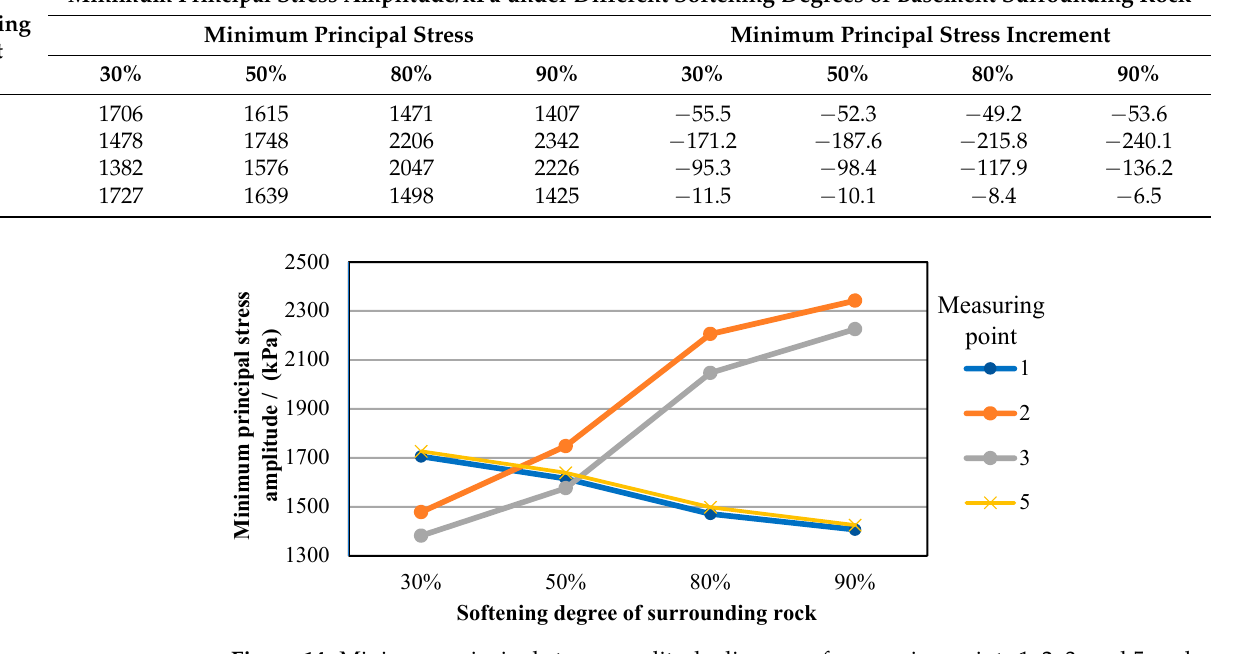
Table 14. Minimum principal stress amplitude of measuring points 1, 2, 3, and 5 under different softening degrees of basement surrounding rock.